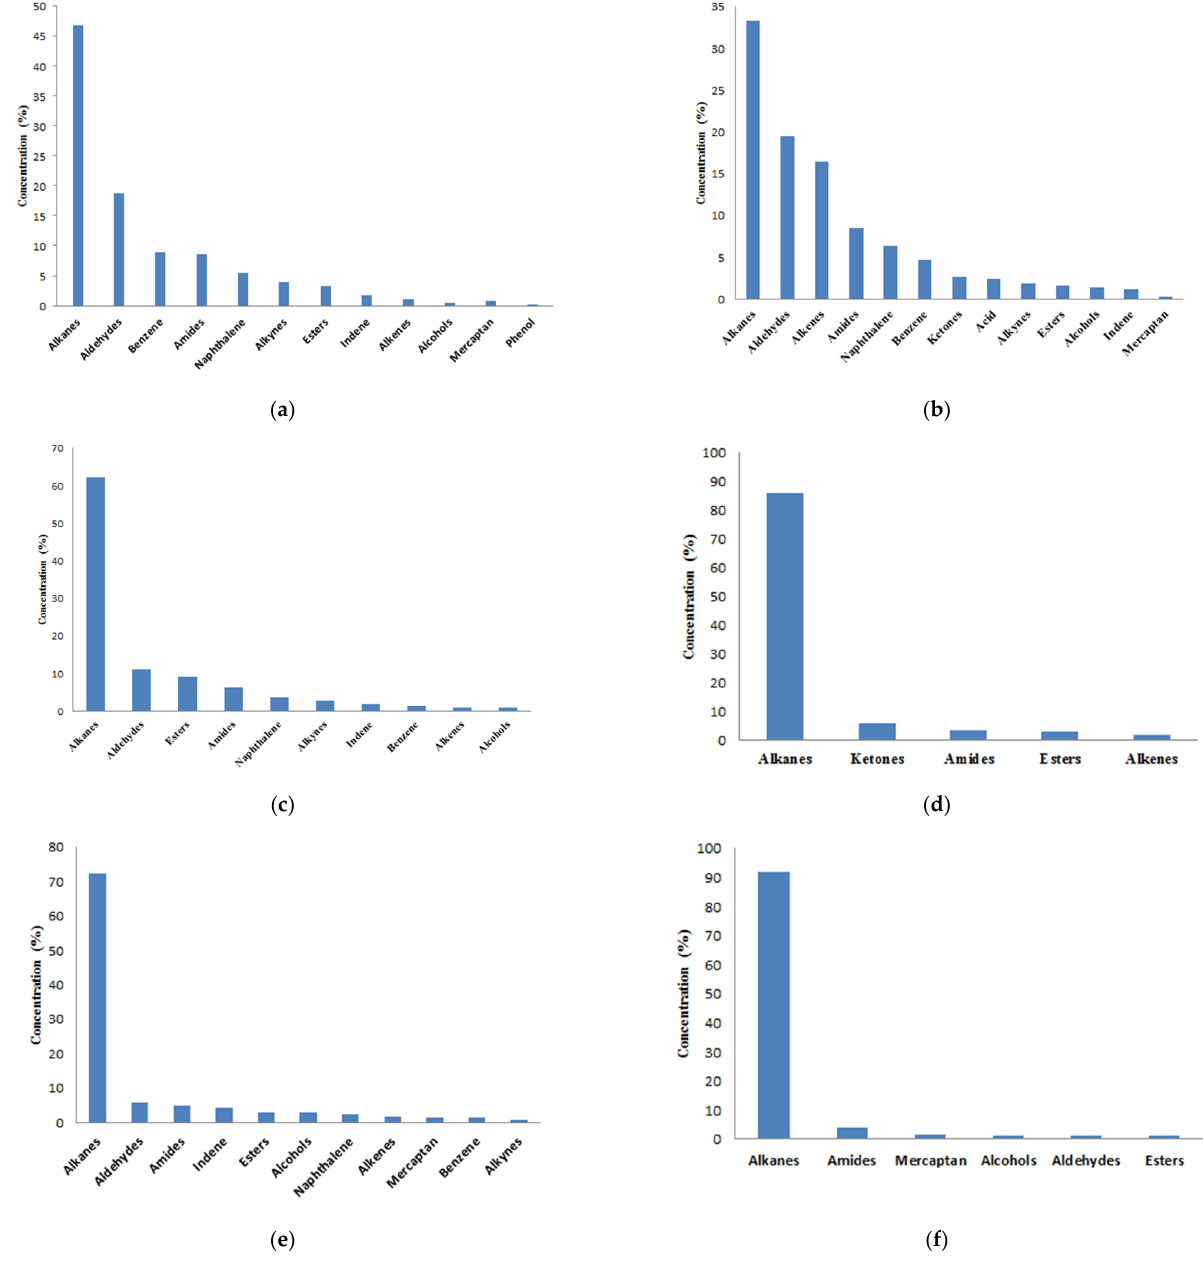
Figure 3. Types and relative percentage of volatile organic compounds determined by gas chromatography–mass spec- trometry (GC–MS): ( a ) nursery-middle-morning; ( b ) nursery-middle-afternoon; ( c ) nursery-window-afternoon; ( d ) chicken-middle-morning; ( e ) chicken-middle-afternoon; ( f ) chicken-window-afternoon.